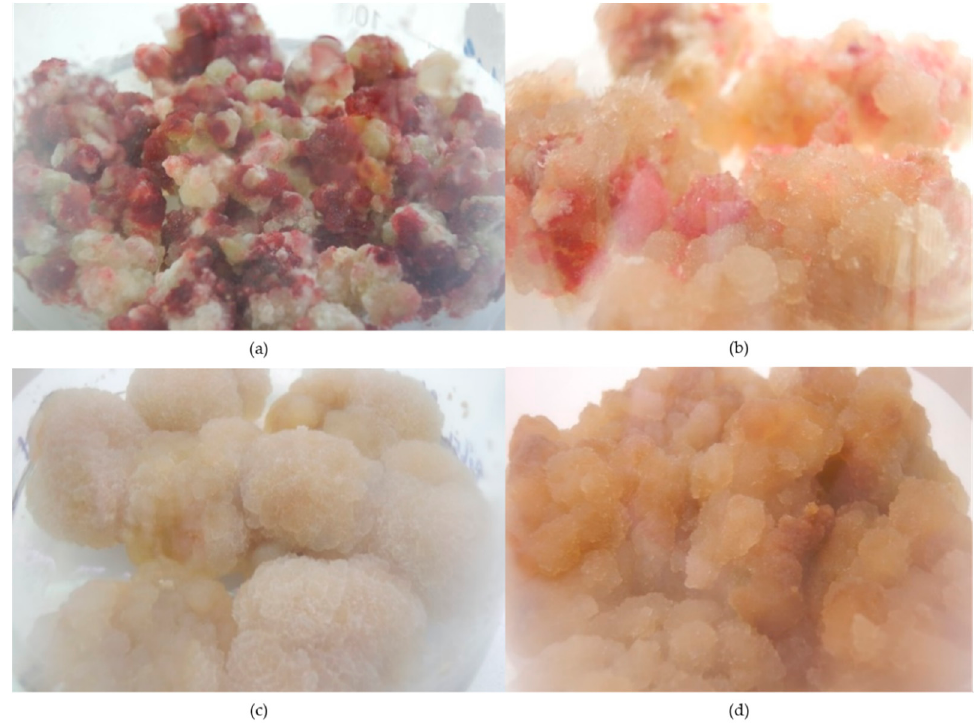
Figure 1. The callus lines of Chaenomeles japonica cultured in vitro on MS (Murashige and Skoog) media ( a ) Line A1: MS + 1.0 mg L − 1 2,4 D + 0.1 mg L − 1 Kin (light); ( b ) Line A2: MS + 1.0 mg L − 1 2,4 D + 0.1 mg L − 1 Kin (dark); ( c ) Line B: MS + 2.0 mg L − 1 2,4 D + 0.2 mg L − 1 NAA ( d ) Line C: MS + 1.0 mg L − 1 DIC.